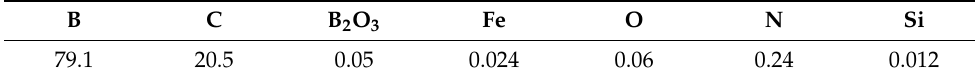
Table 2. Chemical composition of B 4 C particles in weight% [24].